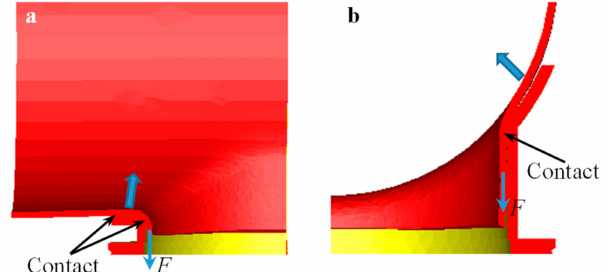
Figure 10. Mechanism of warping of the main pipe, the area around ( a ) the major axis and ( b ) the minor axis of the elliptical prefabricated